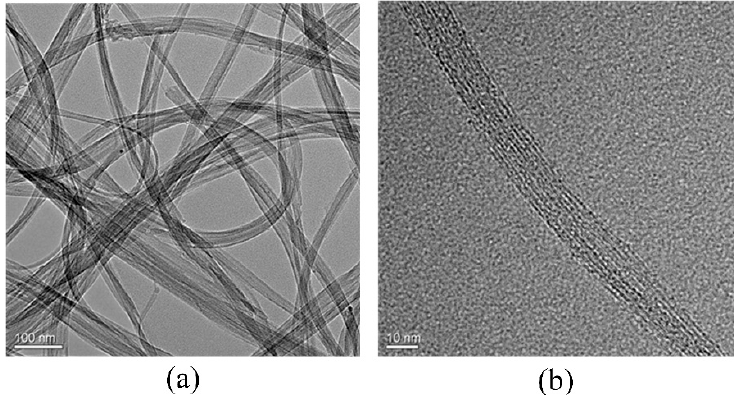
Figure 3. ( a ) The low-resolution TEM image and ( b ) the high-resolution TEM image of the